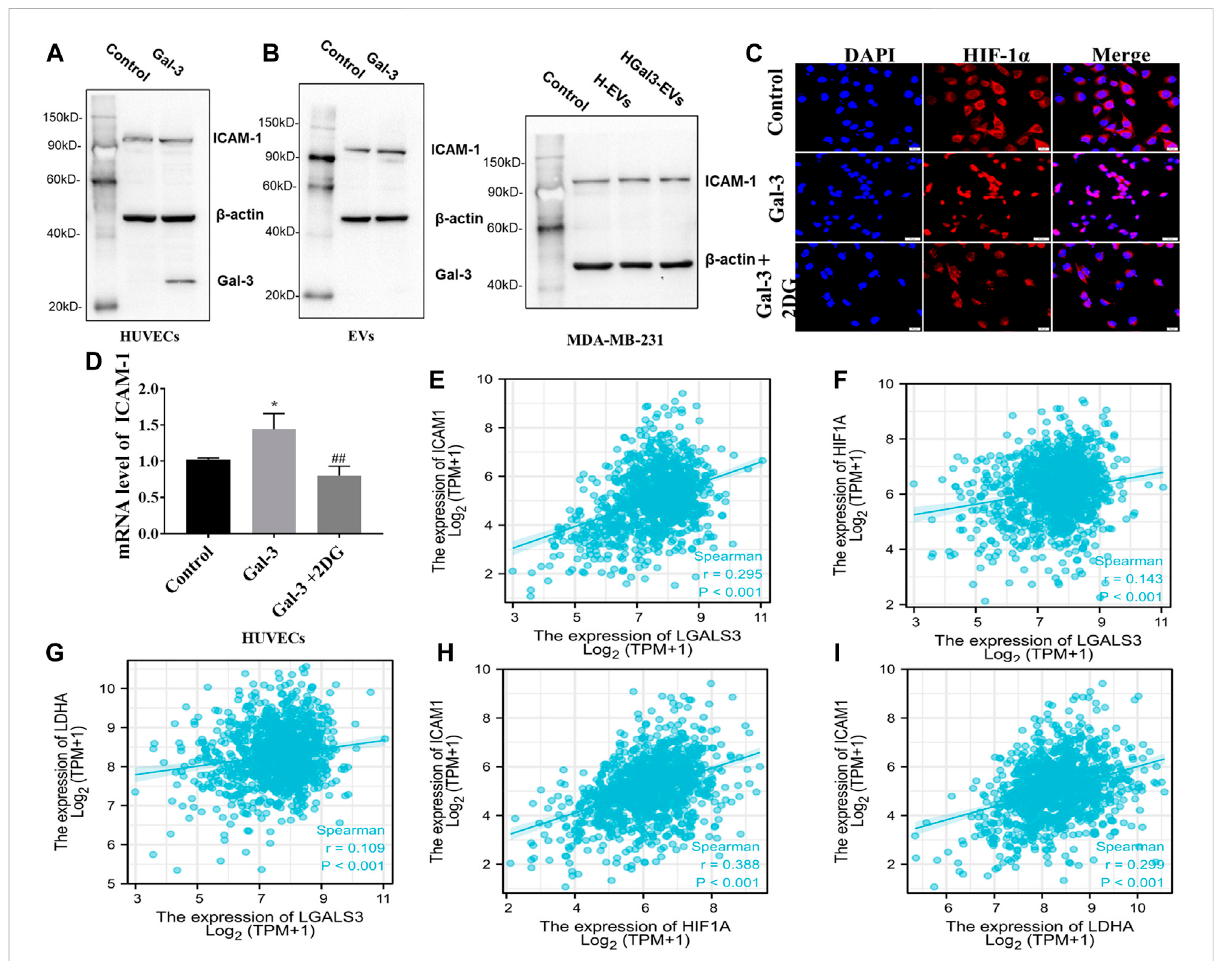
FIGURE 4 Gal-3 upregulates theexpressionofICAM-1 in H-EVs to promote tumor-endothelial adhesion. (A) Expression of ICAM-1 in H-EVs and HUVECs after incubated with 1 ng/ml Gal-3 for 24 h was detected by Western blot. (B) Effect of H-EVs and HGal3-EVs on the expression of ICAM-1 in MDA- MB-231 cells was detected by Western blot. (C) Effect of 2-DG on Gal-3-induced HIF-1 α nucleation in HUVECs were assessed by immuno fl uorescence (magni fi cation, ×100, bar = 200 μ m). (D) Effect of 4 nM 2-DG on the increased mRNA expression of ICAM-1 in HUVECs induced by 1 ng/ml Gal-3 was detected by RT-PCR. (E – I) Lgals3, ICAM1, HIF-1A and LDHA expression from TCGA RNA-seq data were examined for correlation analyses. Correlations between them in BRCA ( n = 1222) were calculated by Spearman rank correlation test. Data are presented as